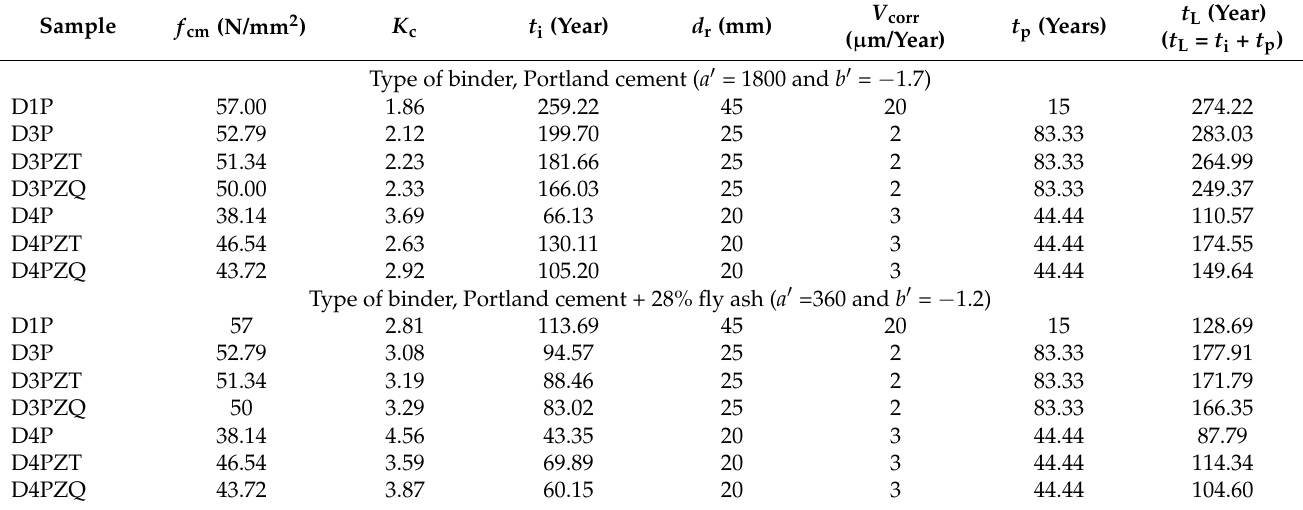
Table 9. Application of the carbonation model for the general calculation method of the useful life. These values were obtained for each type of conglomerate using data extracted from the batches, and the average resistance of the concretes ( f cm